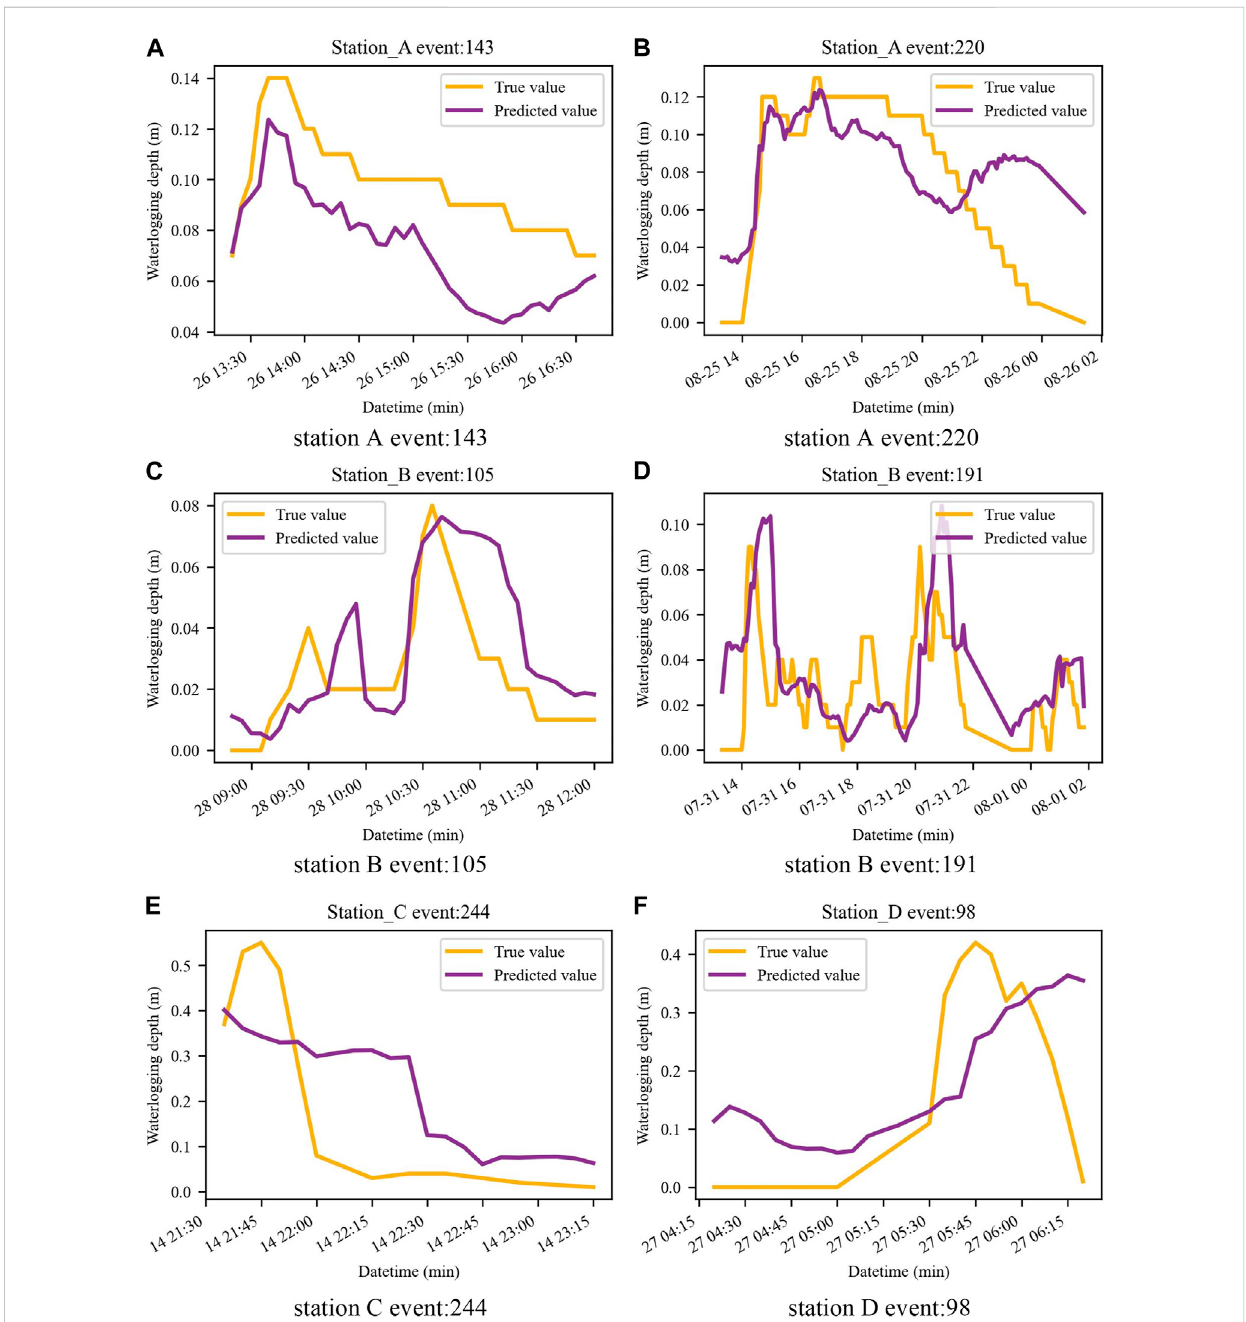
FIGURE 6 Predicteddepthofwaterloggingatfourstations. (A) stationAevent:143; (B) stationAevent:220; (C) stationBevent:105; (D) stationBevent:191; (E) station C event: 244; (F) station D event: